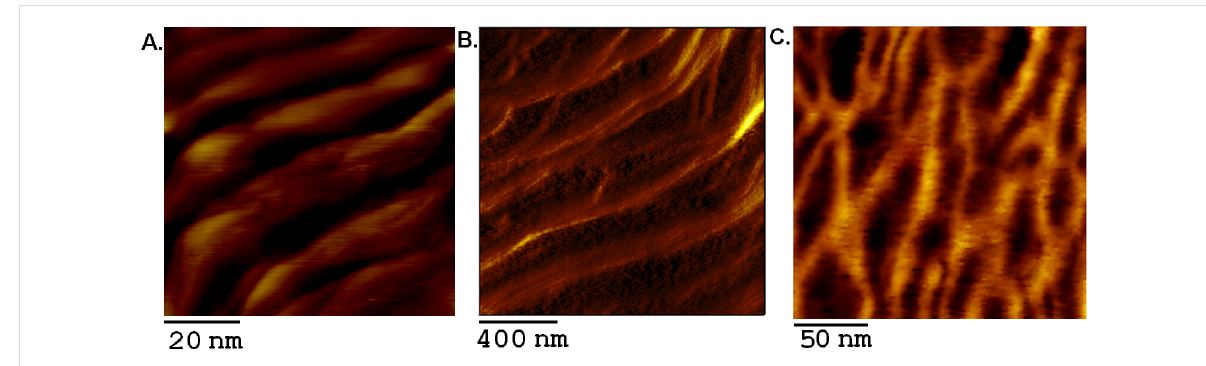
Figure 4: AFM images of the self-assembly of DNA–TPA tri-conjugates. A and B in the presence of Zn PpIX and C in the absence of Zn PpIX.